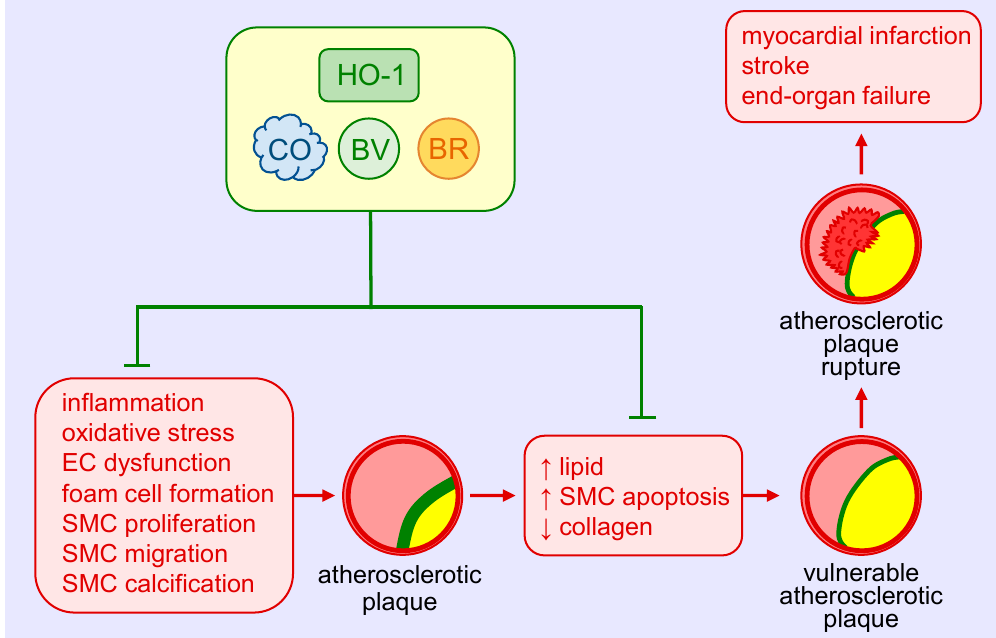
Figure 3. Heme oxygenase-1 (HO-1) inhibits the development and progression of atherosclerosis. HO-1-derived carbon monoxide (CO) and the bile pigments, biliverdin (BV) and bilirubin (BR), avert atherosclerotic plaque formation by blocking vascular inflammation, oxidative stress, endothelial cell (EC) dysfunction, foam cell formation, and vascular smooth muscle cell (SMC) proliferation, migration, and calcification. HO-1 and its products also prevent the development of vulnerable atherosclerotic plaques and plaque rupture as well as thrombosis by limiting lipid accumulation and SMC apoptosis and elevating collagen deposition within arterial lesions. Arterial cross-sections depict the atherosclerotic plaque in yellow, the fibrous cap in green, and thrombus formation in red. Aside from inhibiting the development of atherosclerosis, HO-1 may also prevent the progression of the disease by promoting plaque stability. In patients with carotid artery disease, HO-1 expression is and diminished amounts of SMCs and collagen [101]. A rise in HO-1 expression is also detected in